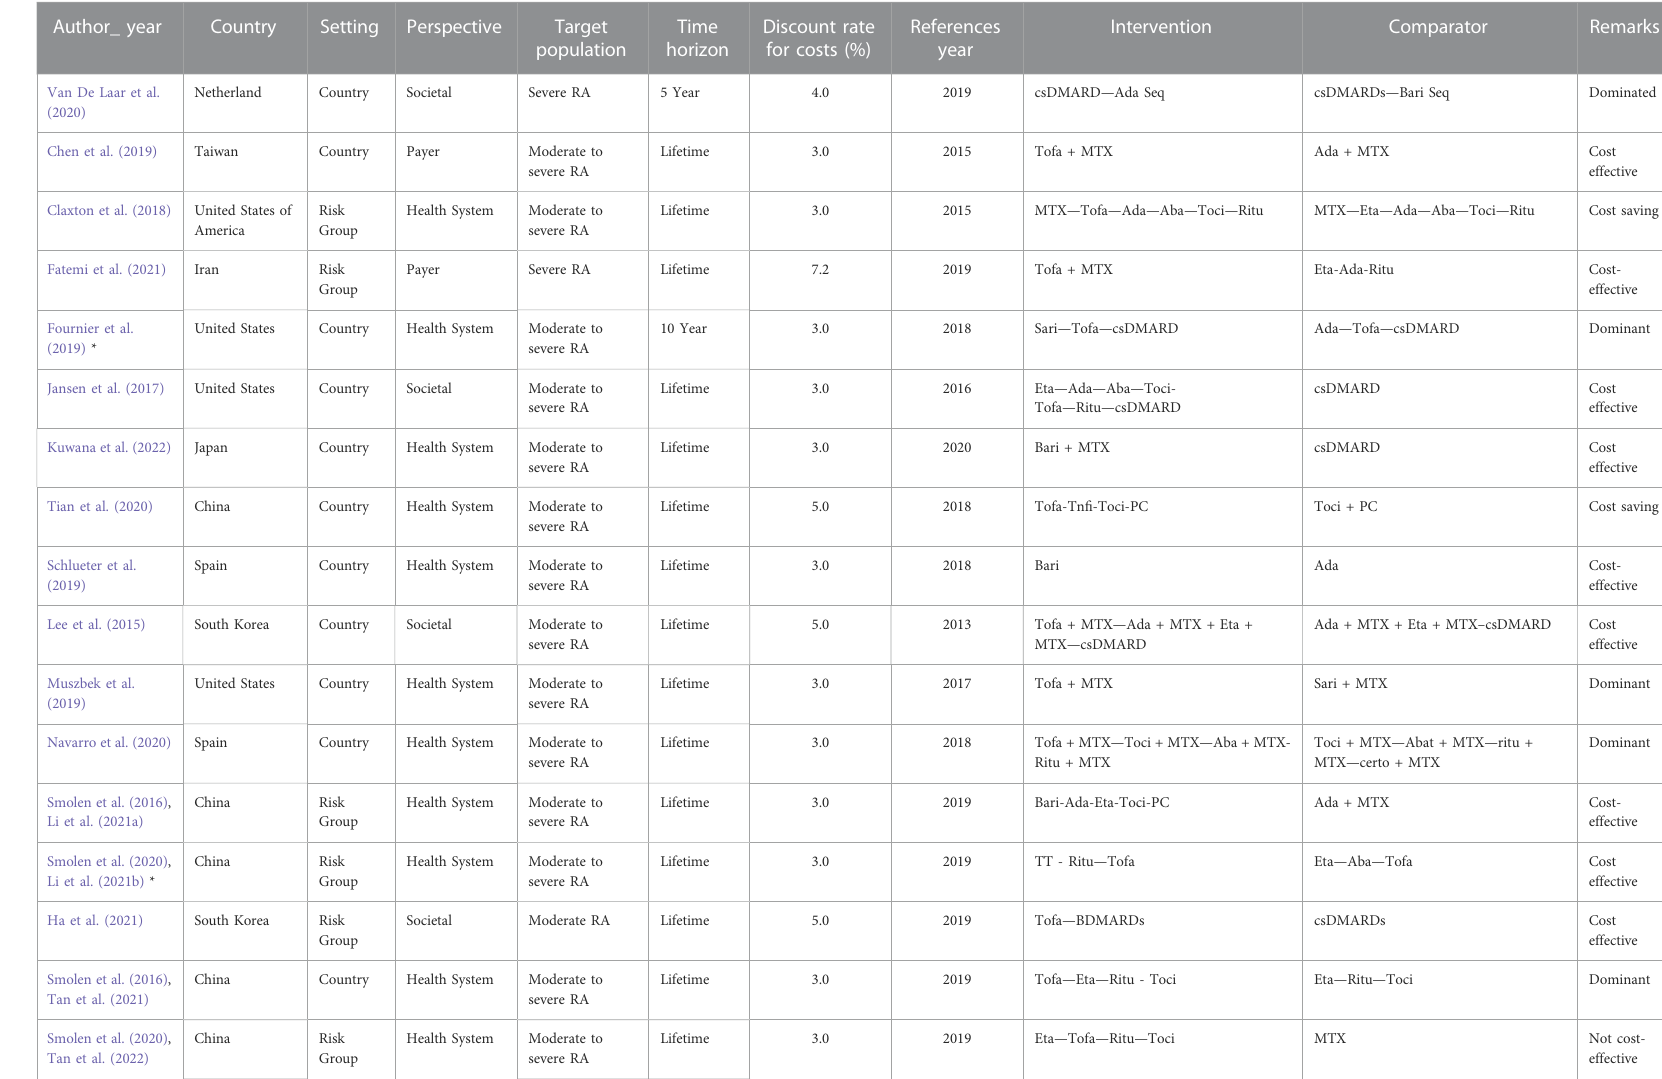
*Systematic review, HIC, High-income country; UMIC, Upper middle-income country; LMIC, Lower middle-income country; NR, not, reported; RA, rheumatoid arthritis; MTX, methotrexate; Aba, abatacept; Ritu, Rituximab; Ada, Adalimumab; Toci, Tocilizumab;Goli,Golimumab;Eta,Etanercept;TT,trippletherapy;Tofa,Tofacitinib;Bari,Baricitinib;Certo,Certolizumab;Sari,Sarilumumab;Le fl ,Le fl unomide;csdmards,conventionalsyntheticdisease-modifyingantirheumaticdrugs;Seq,Sequential; PC, Palliative